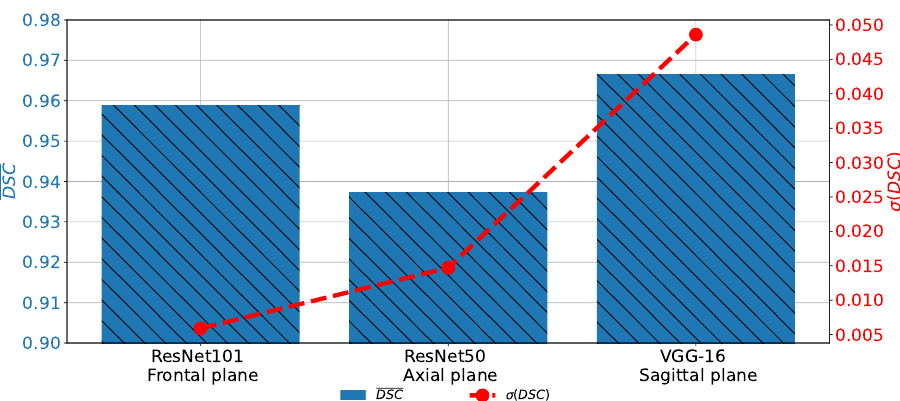
Figure 15. Comparison of DCS and σ ( DSC ) achieved with the most successful architectures for each